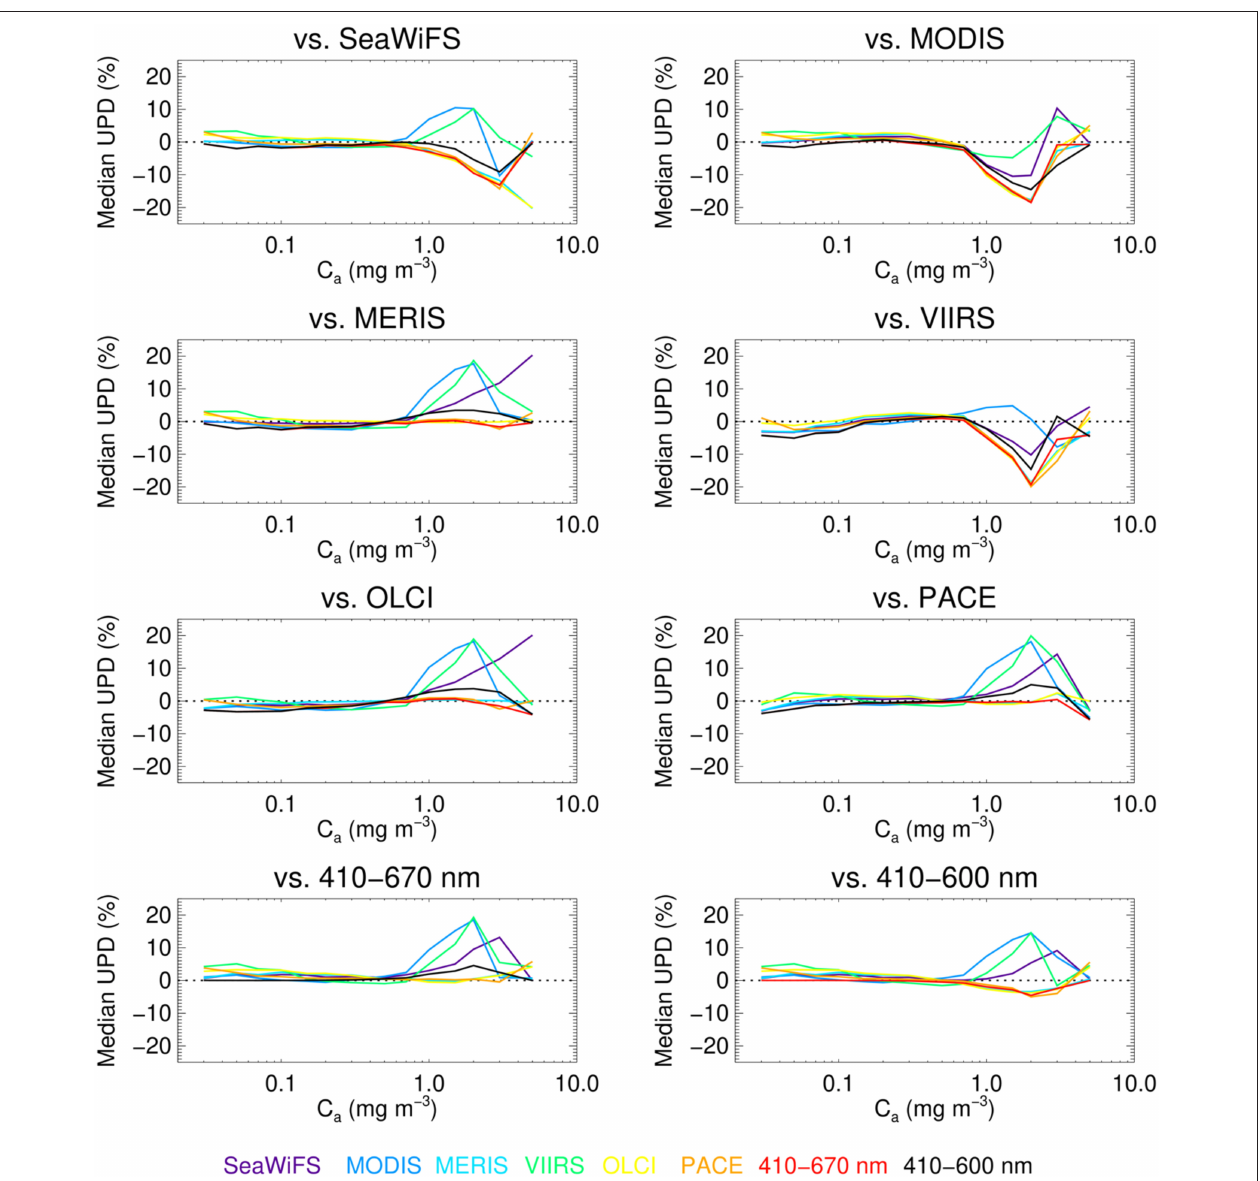
FIGURE 9 | Satellite-to-satellite median UPD for a (443) at each C a interval as for Figure 3 , but cumulatively considering all eight SAA parameterizations introduced in section